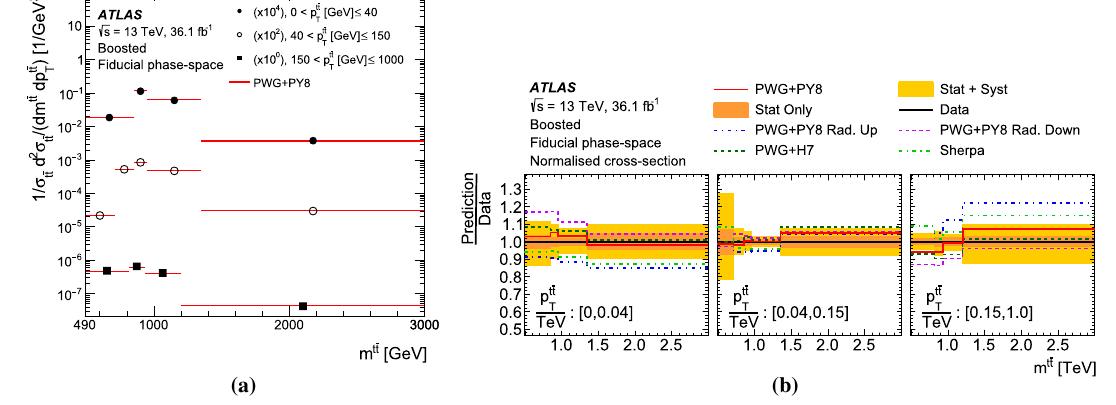
Fig. 48 a Particle-levelnormaliseddifferentialcross-sectionasafunc- generator. Data points are placed at the centre of each bin. b The ratio tion of the mass of the t ¯ t system in bins of p t ¯ t in the boosted topology of the measured cross-section to different Monte Carlo predictions. The T compared with the prediction obtained with the Powheg + Pythia8 MC bands represent the statistical and total uncertainty in the data